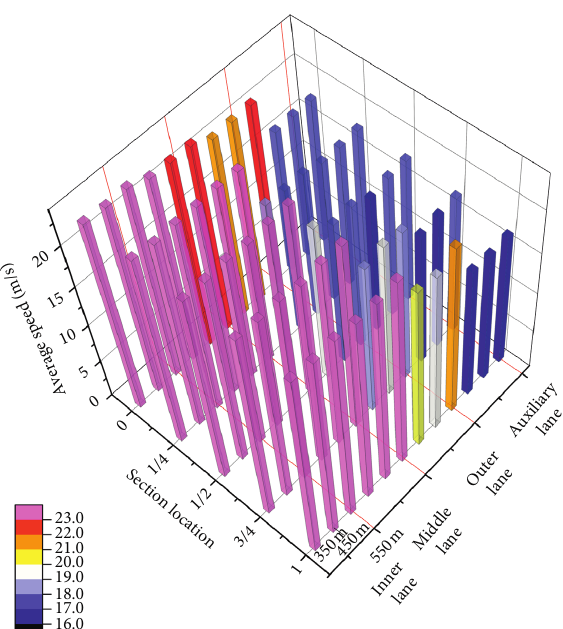
Figure 2: Analysis of average vehicle speed. Figure 3: Analysis of speed standard